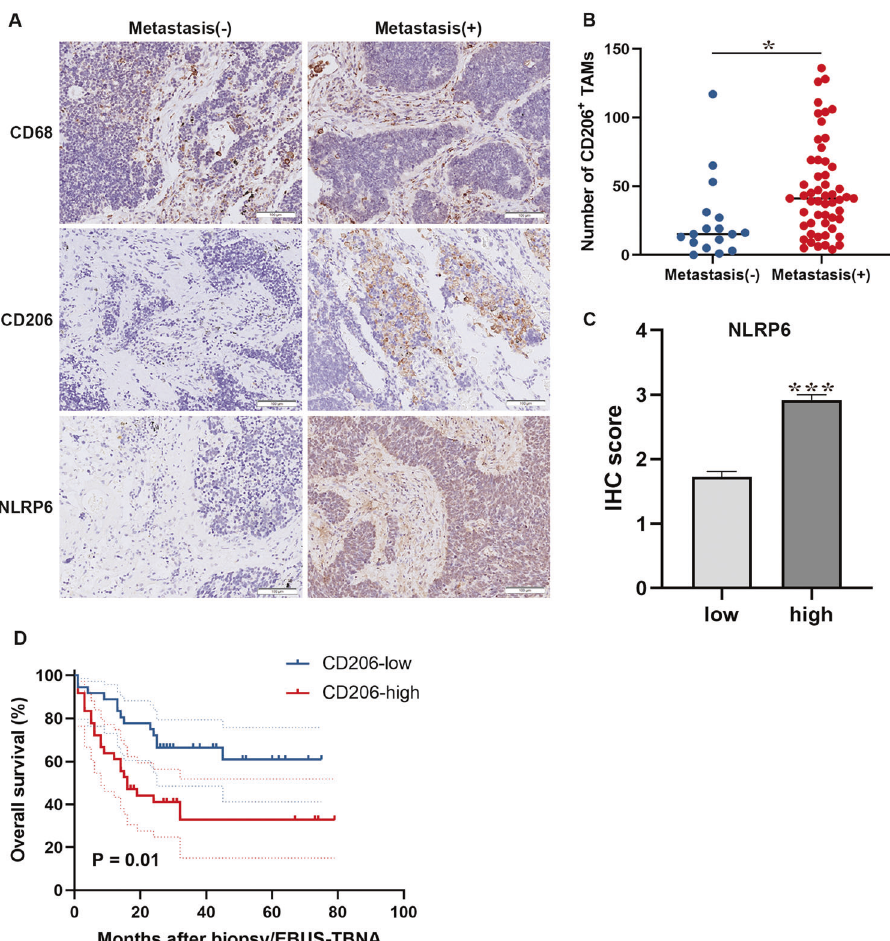
Fig. 1 CD206 + TAMs are correlated with poor prognosis in patients with SCLC. A Representative images of IHC staining for CD68, CD206, and NLRP6 in primary tumors and adjacent regions in patients with SCLC. Scale bar, 100 μ m. B Statistical analysis of the number of CD206 + TAMs in patients with and without metastatic SCLC ( N = 36). C Statistical analysis of NLRP6 IHC score in CD206 high and CD206 low patients with SCLC ( N = 36). D Survival analysis of patients with SCLC based on CD206 expression levels ( N = 36). Bar graphs show the mean ± SEM;